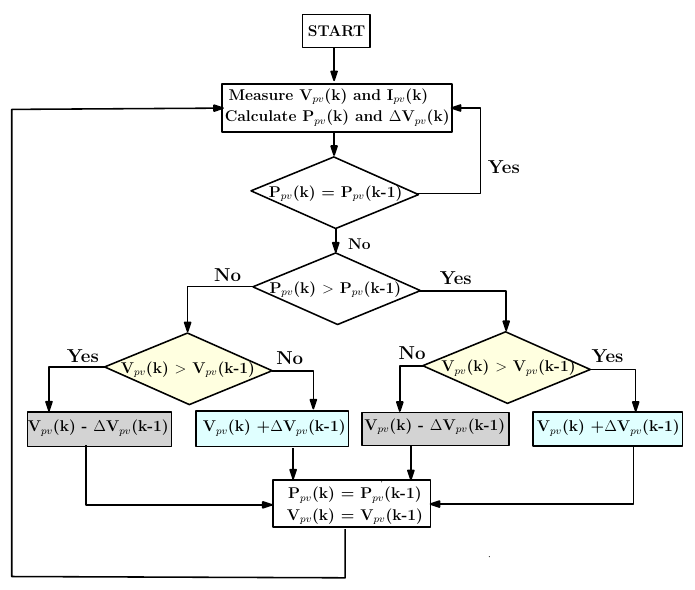
Figure 6. P&O MPPT